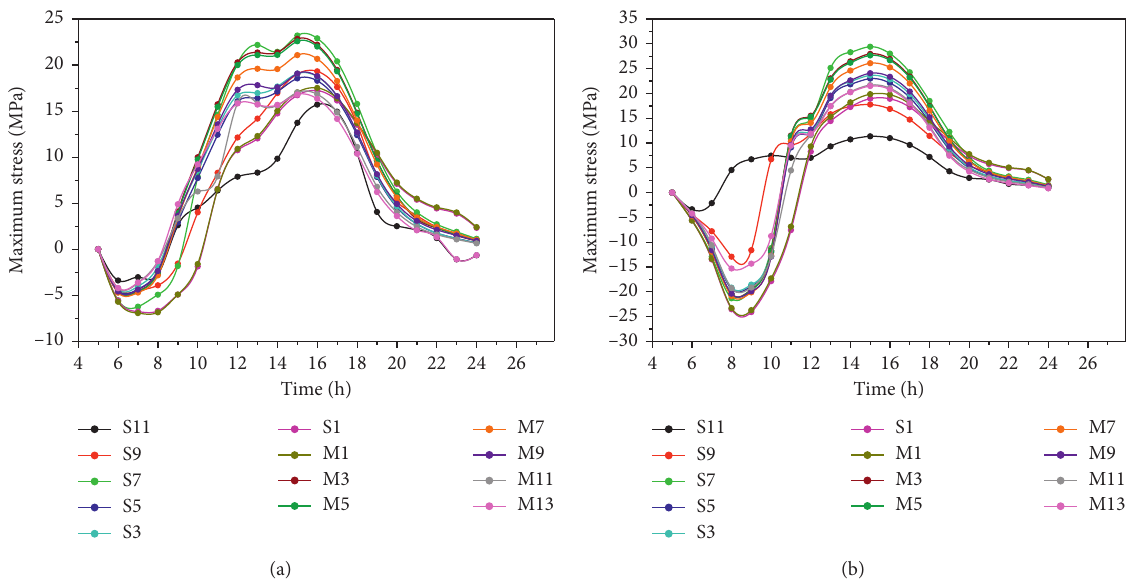
Figure 21: The maximum stress variation of the bottom plate of each segment. (a) The maximum stress variation of the bottom plate of each segment on the west side. (b) The maximum stress variation of the bottom plate of each segment on the east side.